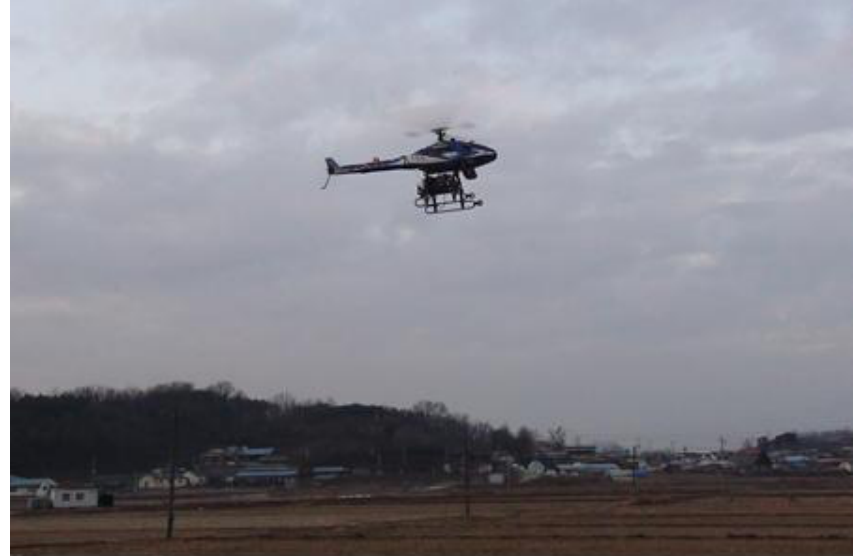
Figure 13. Airborne multi-sensory system during data acquisition over the test site.